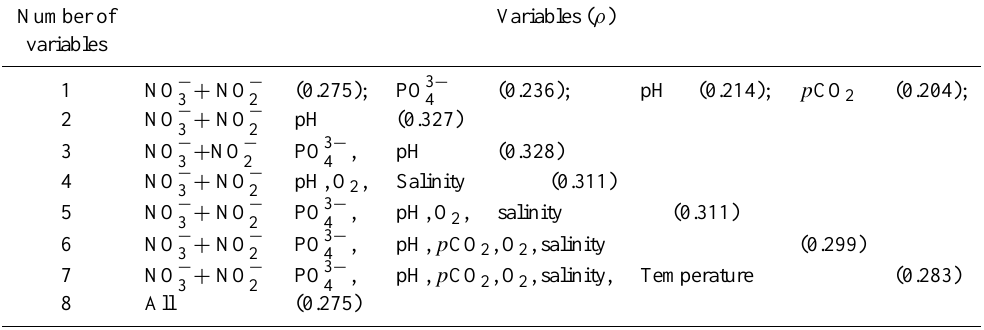
Table 2. Rho values ( ρ ) for the best Spearman’s rank correlations for all possible combinations between the environmental parameters explaining patterns in holococcolithophore assemblages. Only ρ >0.2 are shown. Description as in Table 1. On the left, the number of variables taken into account; on the right, description of the variables and the highest ρ values for the rank correlations at a given number of variables. In the first row, the ρ value for each variable is shown in decreasing order of contribution to explain changes in the biological data. Only ρ >0.2 are shown.